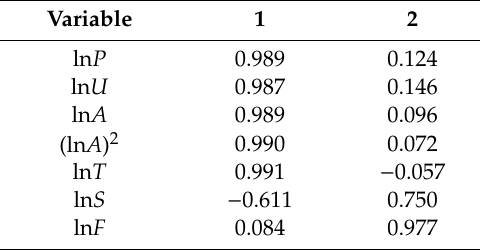
Table 7. Principal component load